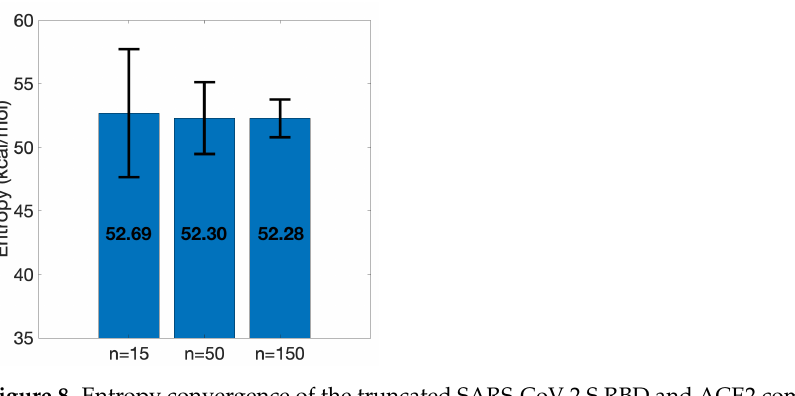
Figure 8. Entropy convergence of the truncated SARS-CoV-2 S RBD and ACE2 complex. Means and standard error of the means are shown. Increasing the number of equidistant sample points from 15 to 150 shows the stability of the entropy around 52 kcal/mol.